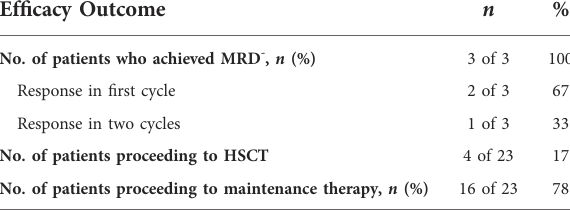
TABLE 2 Ef fi cacy outcomes of 23 patients with